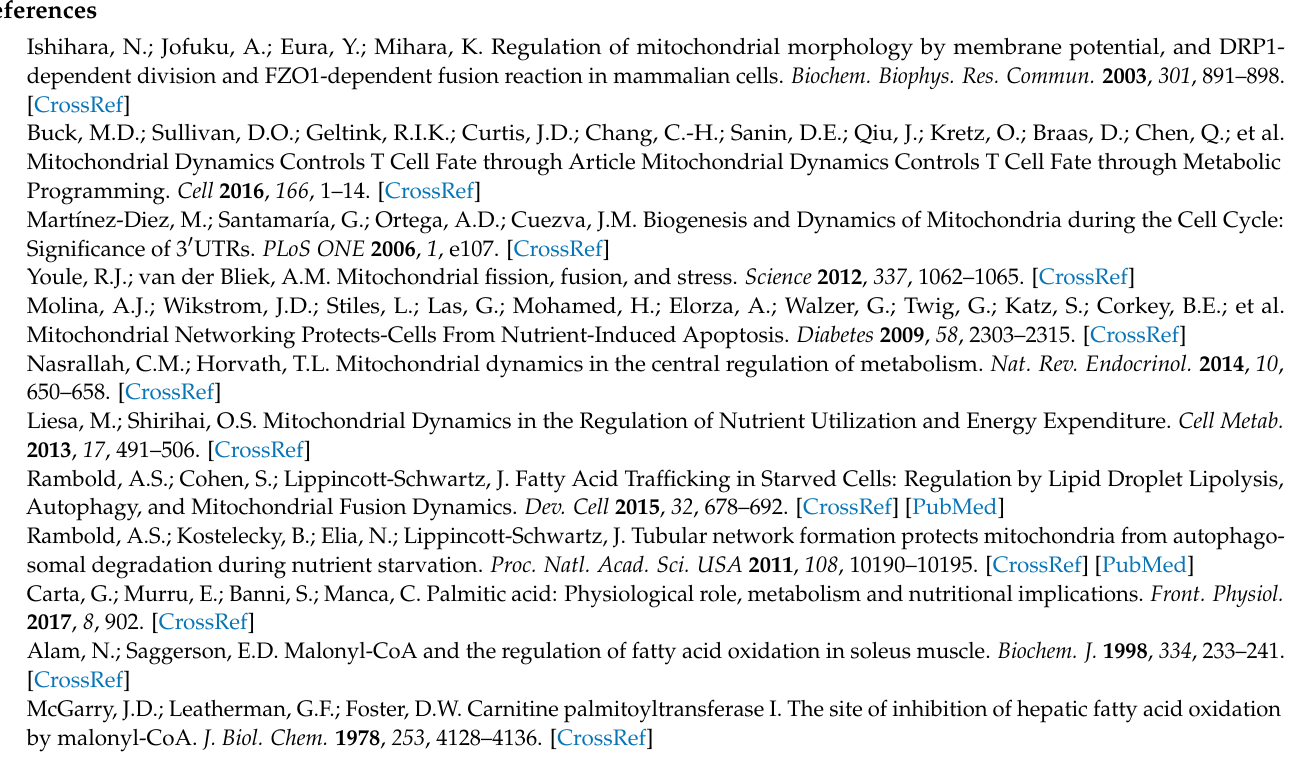
lipid droplets, Figure S4: The effect of DRP1 KD on cellular metabolism, Figure S5: CPT1A OE does not alter the fatty acid storage-usage balance, Figure S6: Morphological changes in mitochondria in CPT1A KD